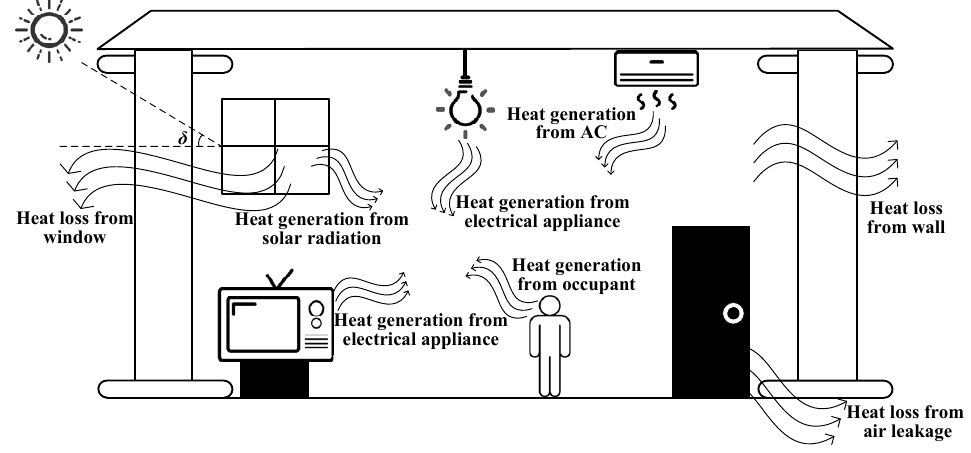
Figure 1. The thermal model of the room.